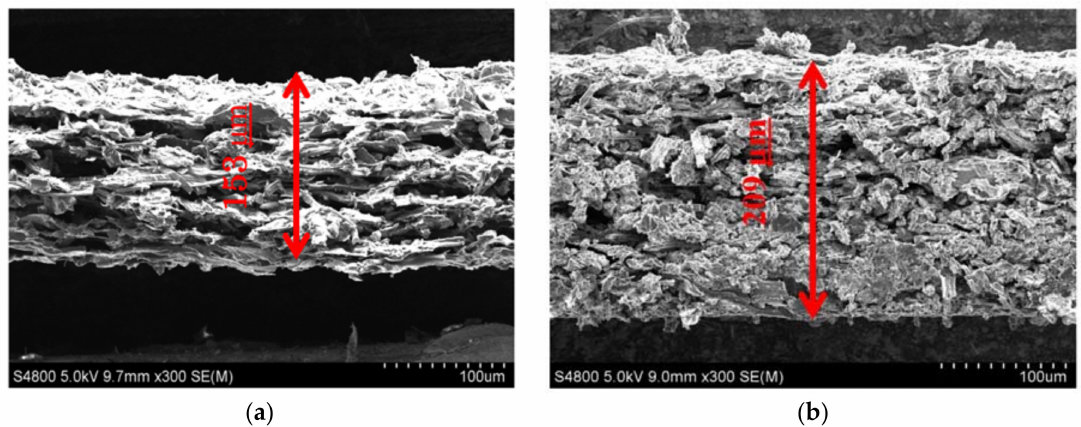
Figure 3. SEM images of the Si/G/CP composite electrode with 16 wt % and 5 µ m Si. ( a ) Initial and ( b ) after 100